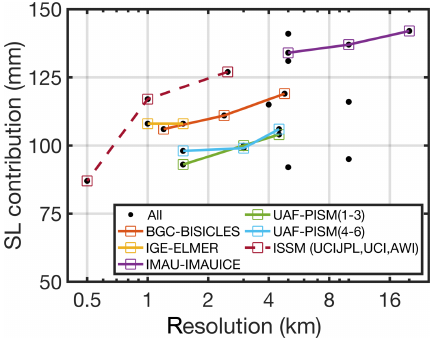
Figure 1. Results from the initMIP-Greenland exercise (Goelzer et al., 2018). Sea-level contribution vs. (minimum) horizontal grid resolution of each participating ISM. Equal model versions but dif- ferent grid resolutions are connected with a coloured line. ISSM model versions are connected with a coloured dashed line. Note the logarithmic scale of the x axis. For unstructured meshes the finest resolution is